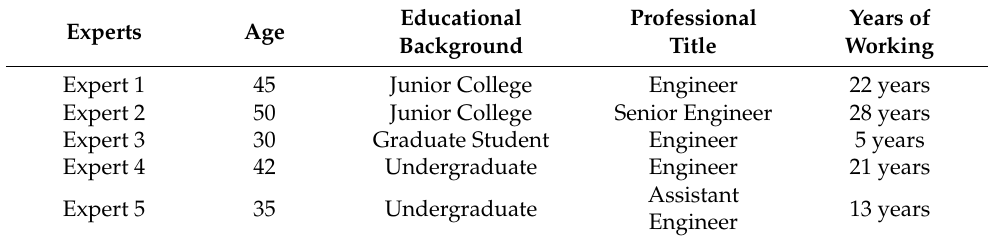
Table 9. Basic information of experts.